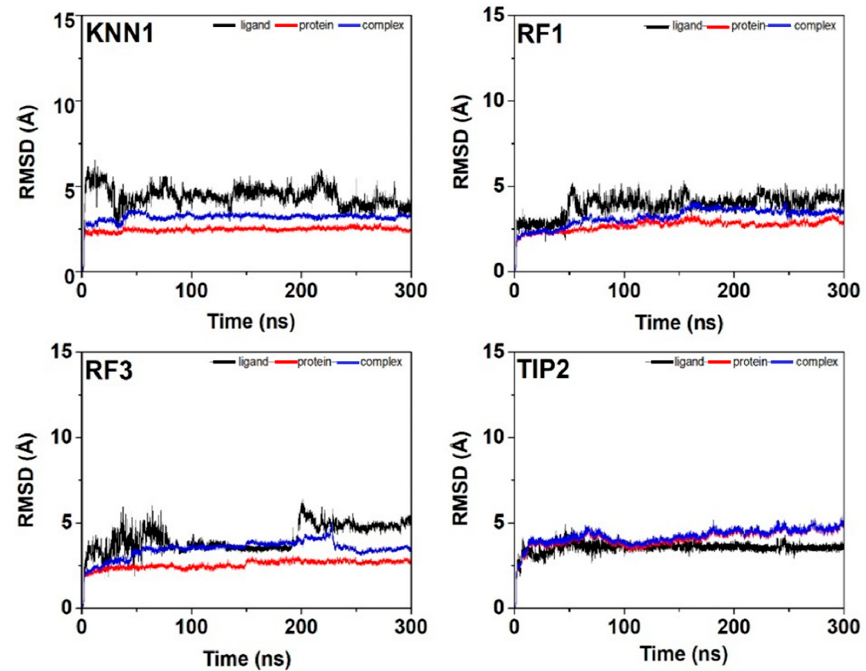
Figure 6. Figure 6. RMSD profiles of the hdTIPs (ligand), tyrosinase protein backbone, and tyrosinase-hdTIPs complexes.